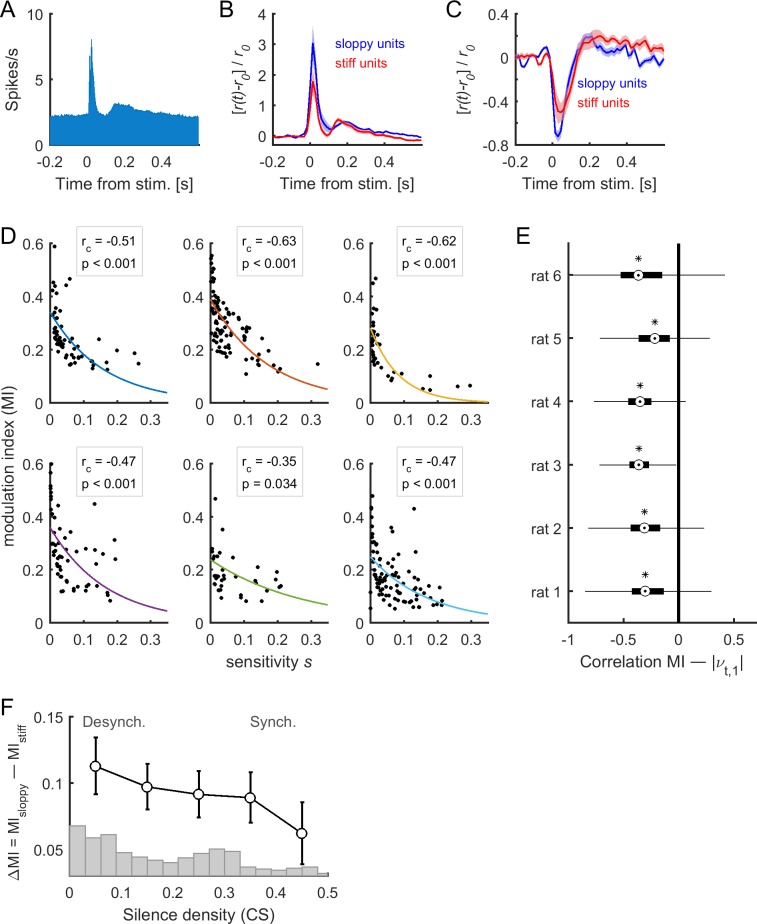
Stimulus-evoked neuronal activity evolved along sloppy dimensions.(A) Population responses to acoustic clicks. (B–C) Median-split of sensitivity s was used to separate stiff neurons and sloppy neurons. The mean responses for stiff and sloppy neurons are shown in the case of excited responses (B) and suppressed responses (C). The responses were normalized by the average pre-stimulus activity r0. Shaded areas correspond to SEM. Data in (A), (B), and (C) correspond to one example rat (#1). (D) Modulation index (MI) as a function of associated sensitivity of firing rates (si, with 1 ≤i≤Npop), for each dataset. Each dot corresponds to a single neuron of the recorded population. The correlation between MI and sensitivity was negative for all datasets (rc: correlation coefficient; p: p-value). Solid lines indicate exponential fits. (E) Correlation between MI(t), calculated in epoch t, and νt,1, for all neuronal ensembles of each of the rats. On each box, the central mark indicates the median, and the bottom and top edges of the box indicate the 25th and 75th percentiles, respectively. Asterisks indicate significantly negative medians (p < 0.001, two-sided signed rank test). (F) Difference of the MI of sloppy neurons minus the MI of stiff neurons as a function of cortical state (i.e., silence density), averaged for all rats (black trace; error bars indicate SEM). The gray bars indicate the distribution of silence density values.